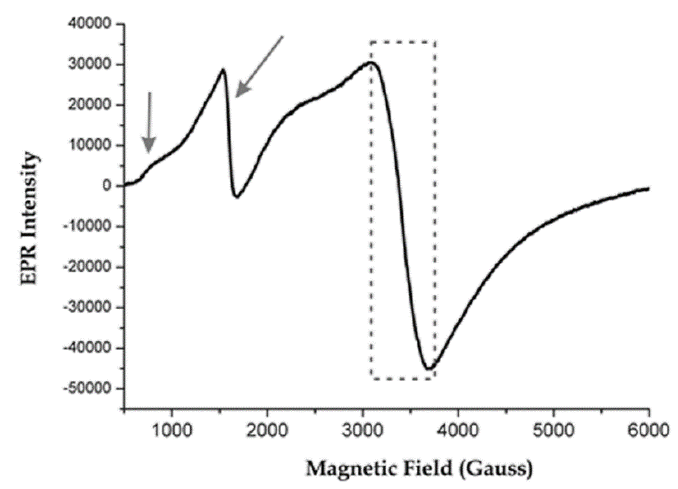
Figure 11. EPR spectrum of sample PN VTR1, equivalent to that of PN VTR2. The arrows highlight the signal of Fe 3+ while the dotted area highlights a shoulder referable to Mn 2+ No signal referable to copper was identified.